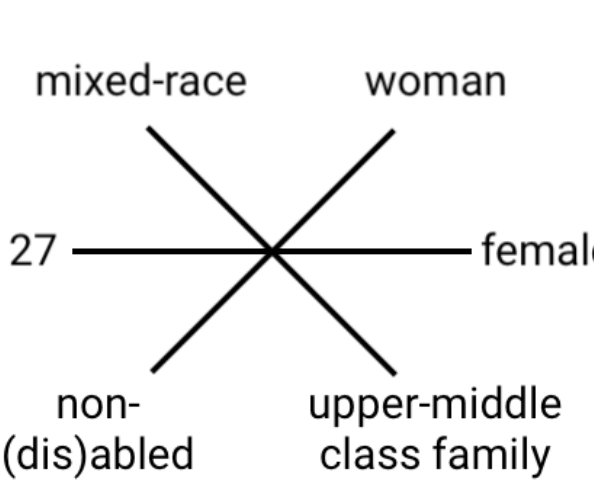
FIGURE 2 . INTERSECTIONAL MAP (COMPLETED). AN EXAMPLE OF THE INTERSECTIONAL MAP TEMPLATE, FILLED OUT WITH SIX POSITIONALITY FACTORS OF ONE OF THE